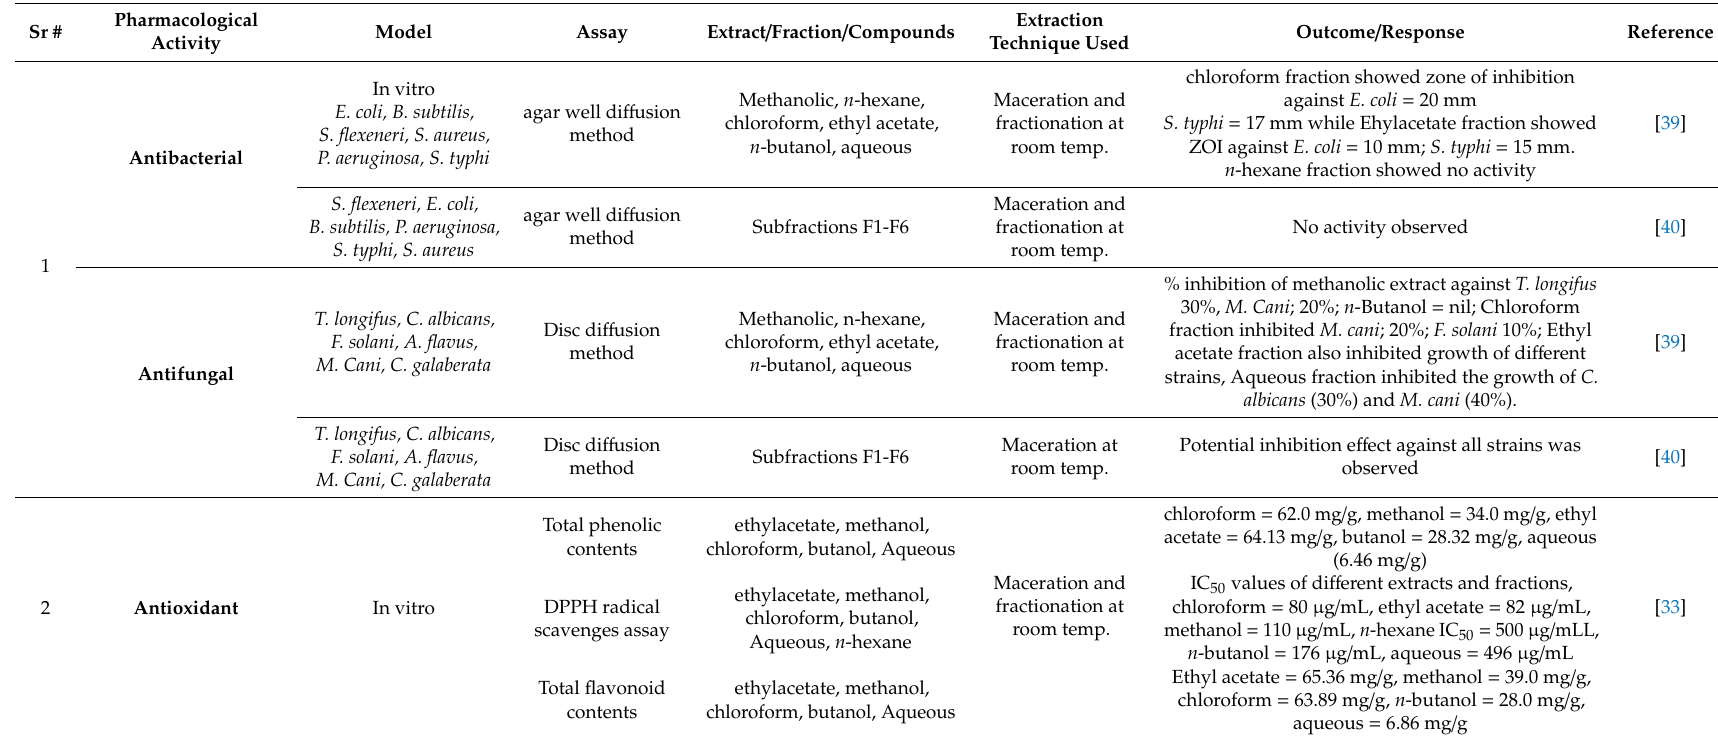
Table 3. Pharmacological activities of whole V. betonicifolia